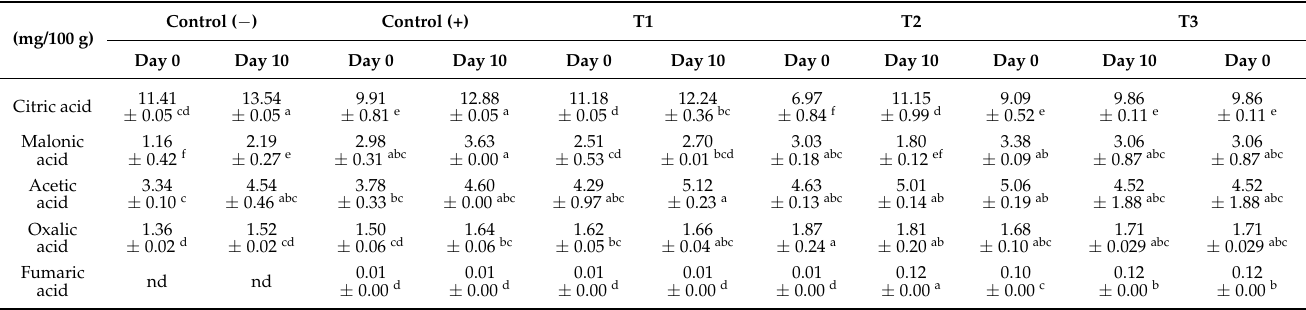
Figure 3. Chromatogram of the standard solution of the organic acids. ( A ) Citric acid, ( B ) malonic acid, ( C ) acetic acid, ( D ) oxalic acid, and fumaric acid. Table 8. Organic acid contents of the patty at different storage times (Day 0, Day 10).